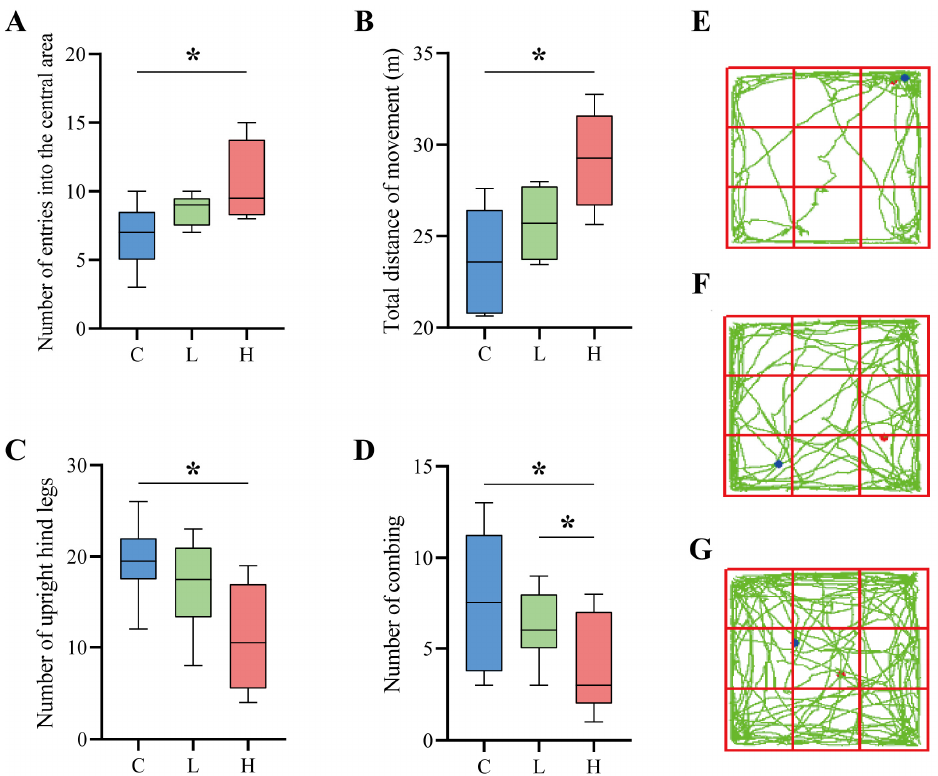
Figure 5. Results of the open-field experiment. ( A – D ) Parameters of the open field experiment. ( A ) indicates the number of times the mice entered the central area of the open field, ( B ) indicates the total distance the mice moved in the open field, ( C ) indicates the number of times the mice stood upright on their hind limbs during the open field experiment, ( D ) indicates the number of times the mice groomed during the open-field experiment; * indicates p < 0.05. ( E – G ) In the open field experiment, there are behavioural pathways of mice, with red dots in the diagram indicating the starting point and blue dots showing the endpoint. ( E ) denotes control group C, ( F ) denotes low-dose group L, and ( G ) denotes high-dose group